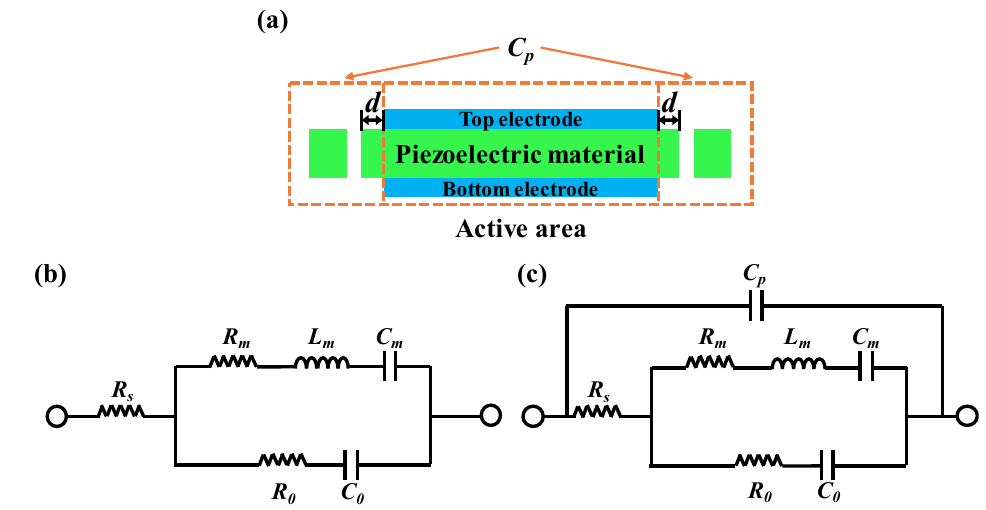
Figure 1. ( a ) Cross-sectional structure of FBAR with the etching trench. ( b ) The MBVD model of FBAR without C p . ( c ) The MBVD model with C p .